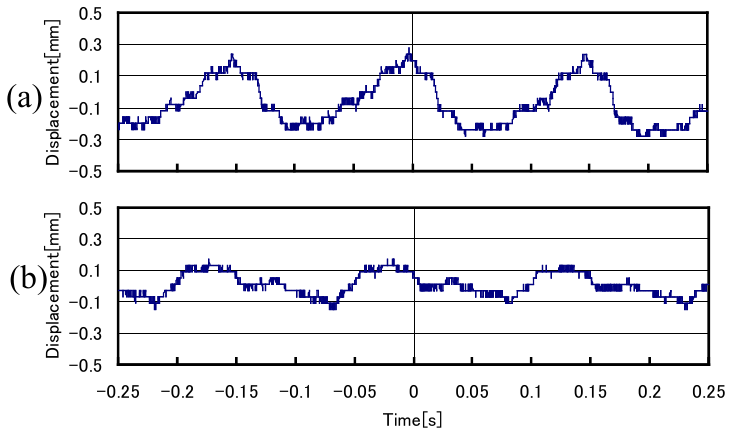
Figure 12. Free-run experimental results in the case of a fixed stator, representing ( a ) displacements of an upper position of the rotor (upper figure) and ( b ) displacements at a lower position of the rotor (lower figure) at a speed of ≈ 400 rpm.